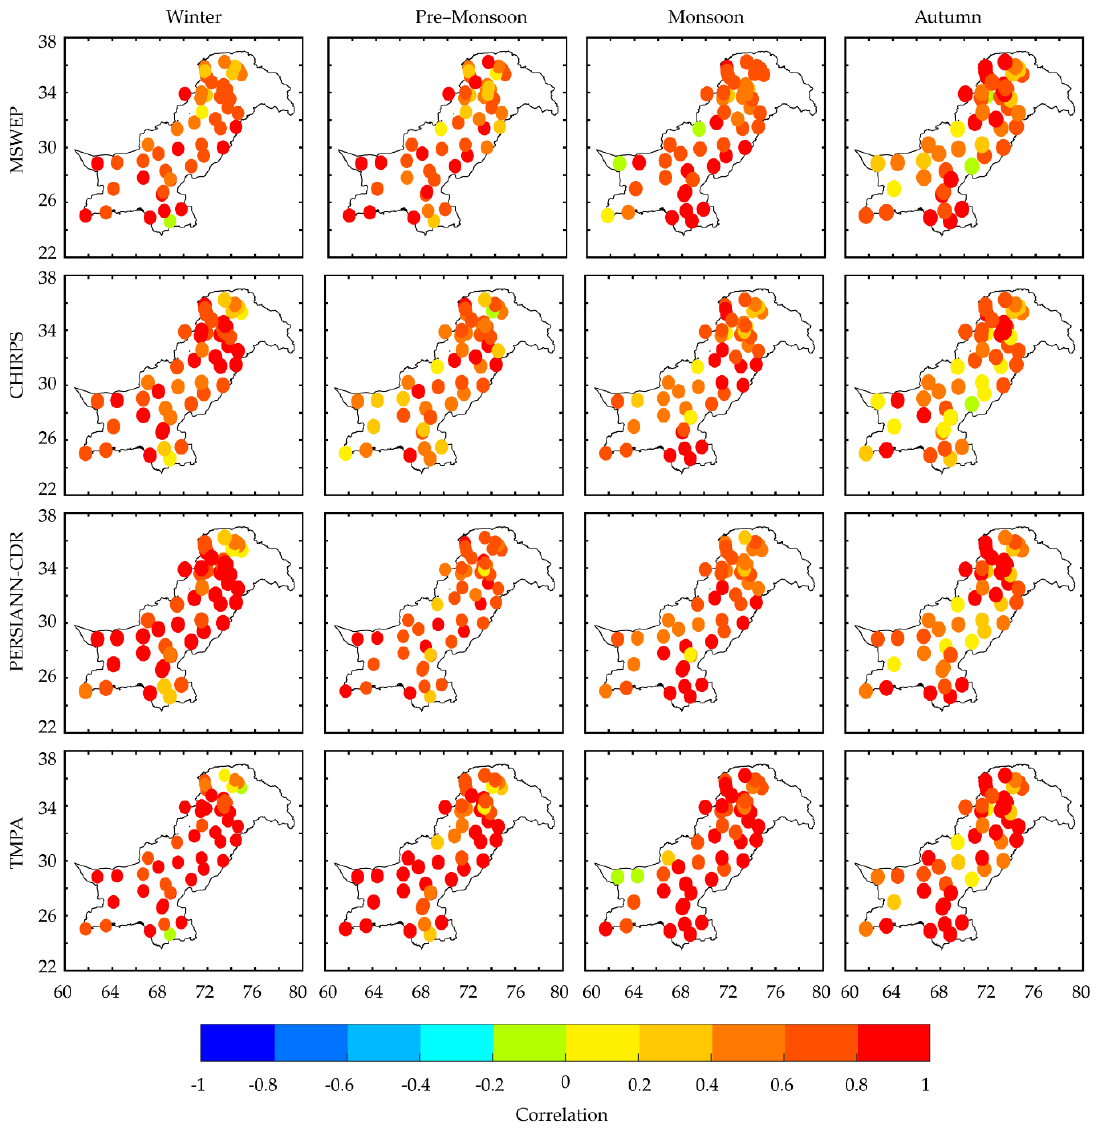
Figure 8. Interannual correlation of in-situ and GPPs precipitation for different seasons.